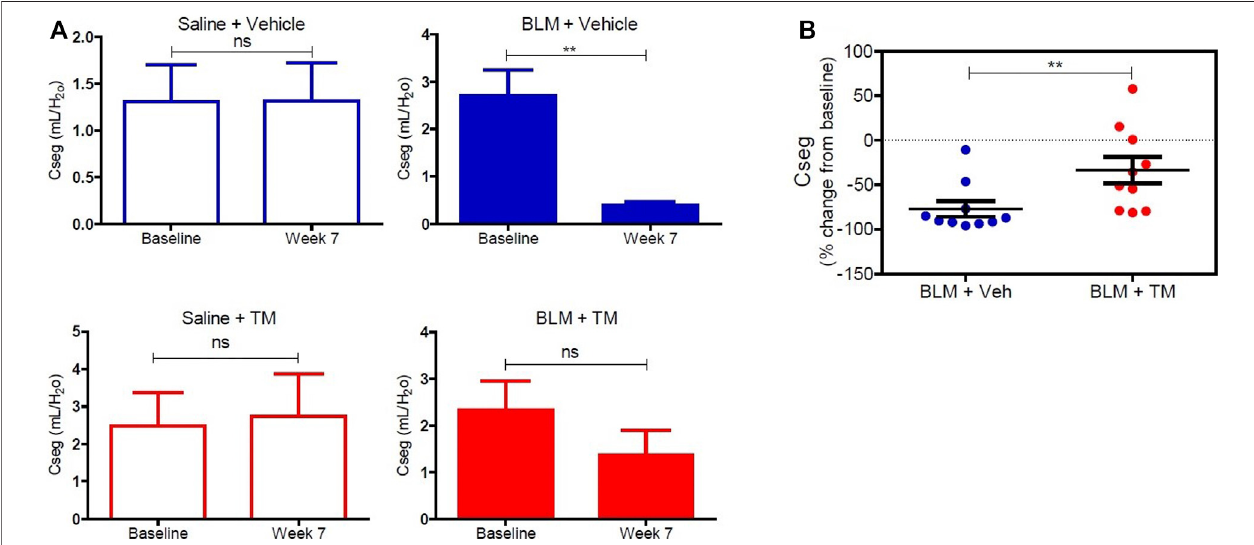
FIGURE 6 | Lung compliance in differentially treated lung tissue sections. (A) Lung compliance at baseline and week seven post bleomycin injury in all differentially treated segments. Segments receiving saline and vehicle (saline + vehicle) control showed no signi fi cant difference in compliance. However, bleomycin-infused segments [with vehicle (sterile PBS), as a control for TM administration (bleomycin + vehicle)] showed a signi fi cant drop in compliance at 7 weeks from baseline. Saline segments that received TM (saline + TM) treatment showed no signi fi cant change. Bleomycin-infused segments that received TM (bleomycin + TM) showed comparablecomplianceatweeksevenandbaseline. (B) Acomparisonofpercentchangefrombaselineatweekseveninbleomycininjuredsegments ofvehicleandTM treated animals. There is a signi fi cant increase in lung compliance in the sheep that received TM compared with the sheep treated with vehicle control only. Signi fi cance wasdeterminedusingapaired t -testbetweenlungsegmentsfromthesametreatmentgroupandanunpaired t -testbetweenlungsegmentsfromdifferentgroups,** p < 0.01, ns-not signi fi cant. Data represent mean ( ±